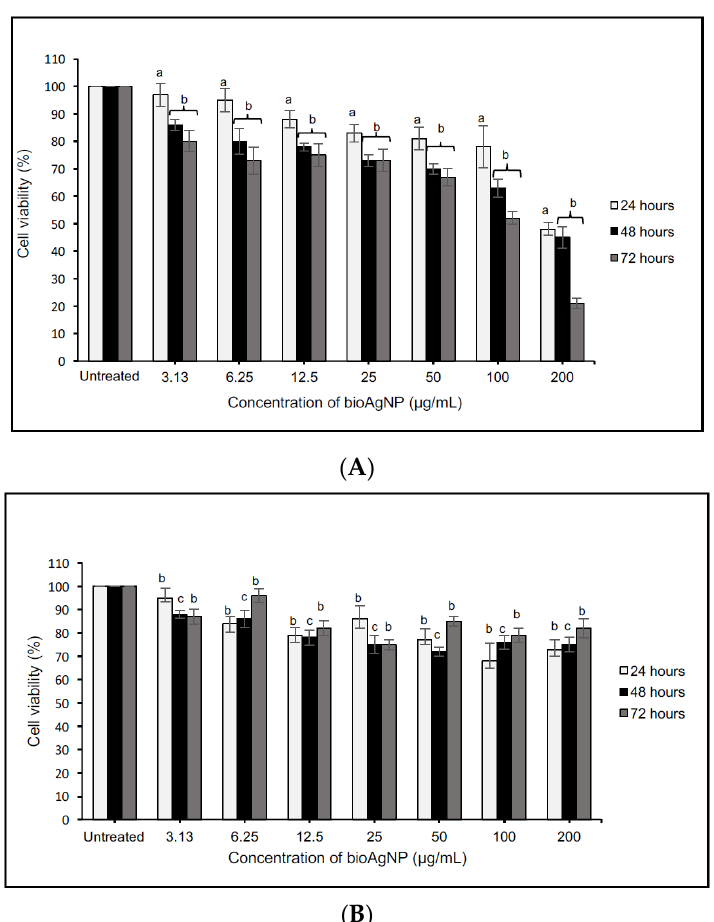
Figure 6. Cytotoxicity analysis of various concentrations of bioAgNPs against DBTRG-0.5MG ( A ) and SVG-p12 ( B ) cells within 24–72 h of treatment. The values presented are the means ± S.E. from three independent experiments. Statistical analysis was performed using Student’s t -test with a p < 0.05, mboxtextsuperscriptb p < 0.01, and c p < 0.001 significantly different to the untreated